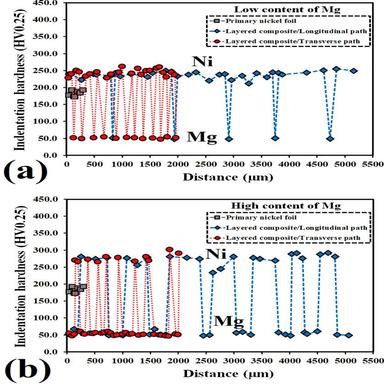
The indentation micro-hardness profiles along with the longitudinal and transverse paths across the thickness section of accumulative fold-forged layered composite structures with (a) low and (b) high stoichiometry of magnesium particles concerning the pure nickel foil as the reference state by addressing the soft (Mg) and hard (Ni) regions.